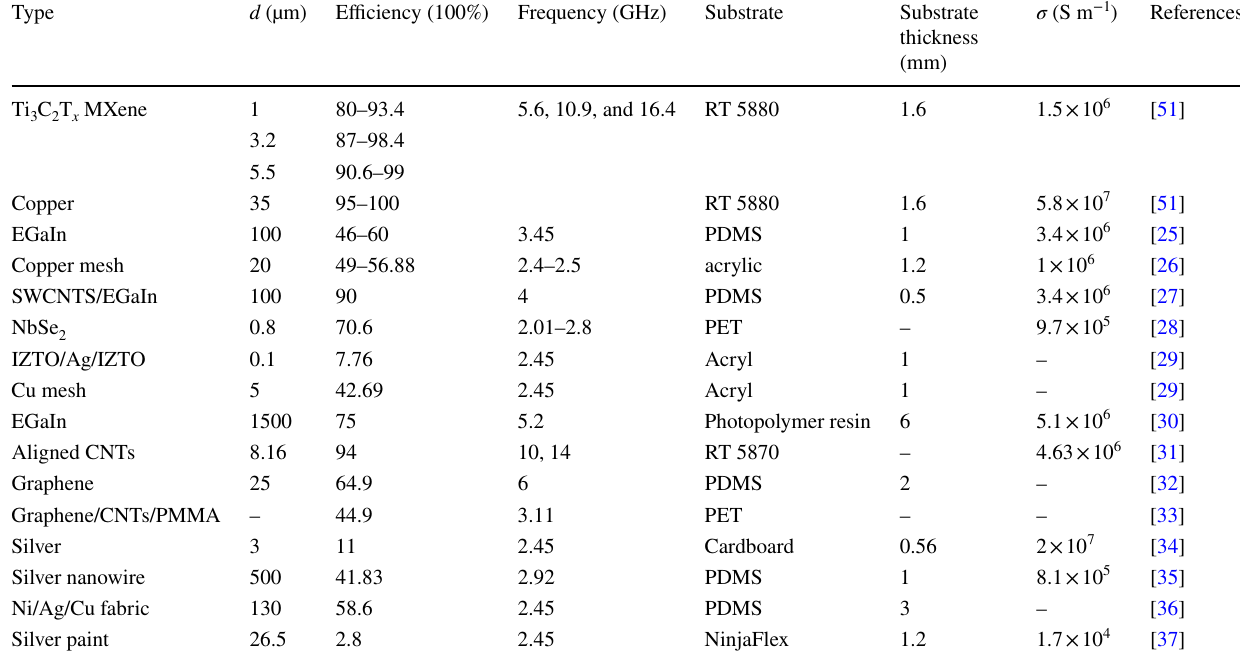
Table 1 The comprehensive performance of patch antennas made of different materials Type